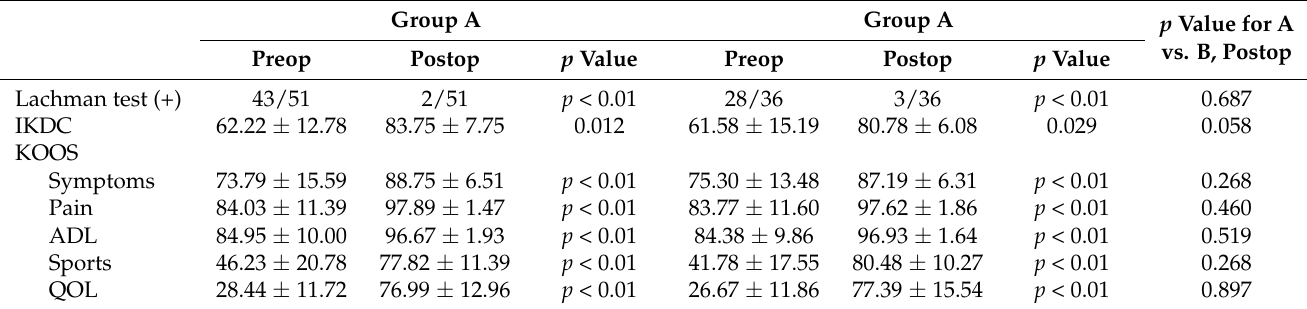
Table 4. Clinical